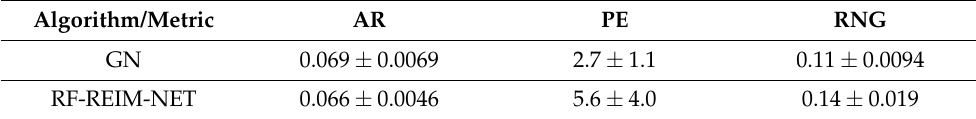
Figure 4. Illustration of RF-REIM-NET ( middle ) and GN ( bottom ) reconstructions of FEM that mimic the position of the tank pickle data. The ground truth target positions are given at the ( top ). Table 1. Figures of merit for the simulated FEM data. Given is the mean ± std . Algorithm/Metric